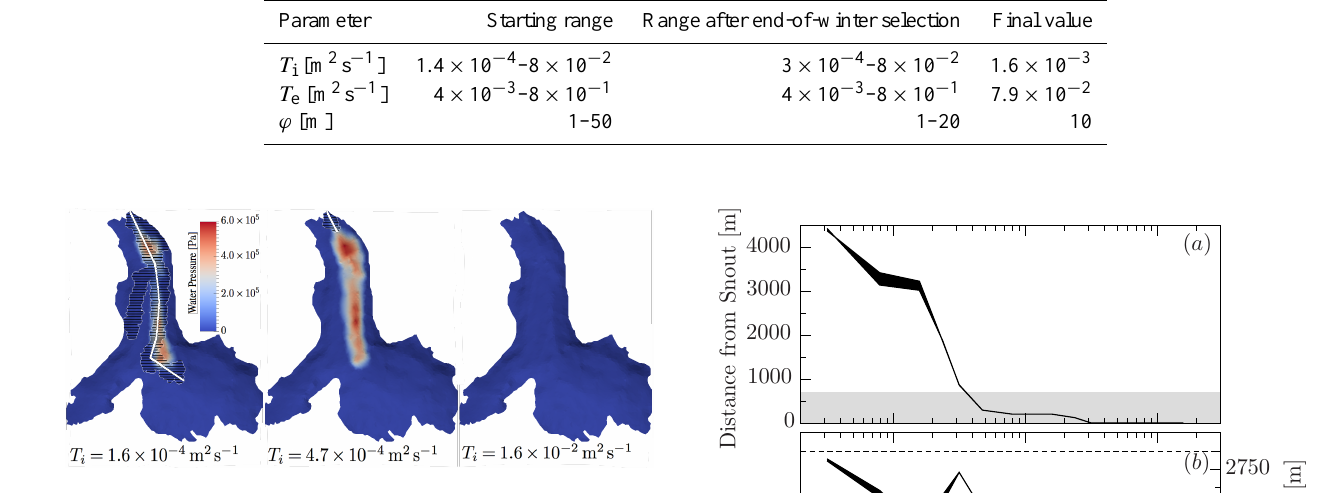
Fig. 5. Maps of Arolla Glacier showing the water pressure of the IDS and the development of the EPL (hatched zone) at the end of the winter season for three different IDS transmissivity values ( T i ). For the highest IDS transmissivity, all the produced water is drained by the sediment layer, explaining the very low water pressure and the non-development of the EPL. The white thick line indicates how the length of the EPL is determined.